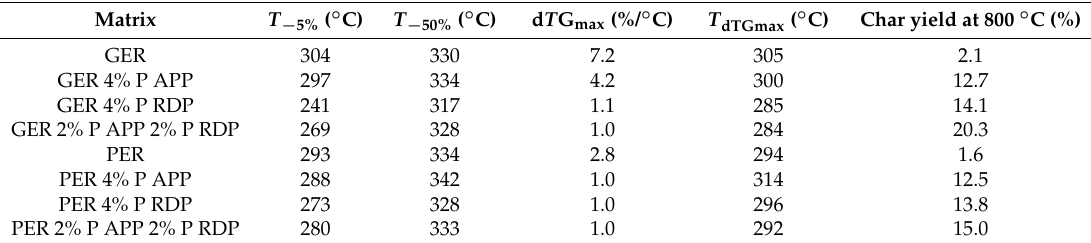
Table 4. Thermogravimetric analysis (TGA) results of the reference and flame retarded GER and PER matrix samples.